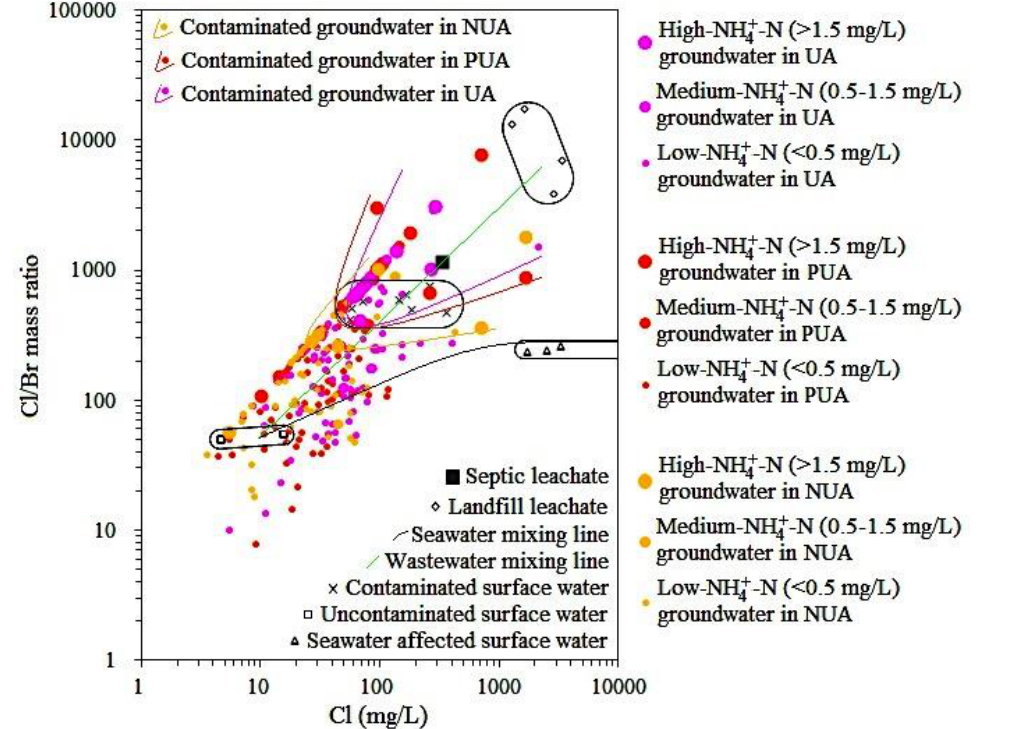
Figure 3. Plot of Cl/Br mass ratios versus Cl concentrations in porous aquifers in areas with different urbanization levels (UA-urbanized area, PUA-peri-urban area, and NUA-non-urbanized area).